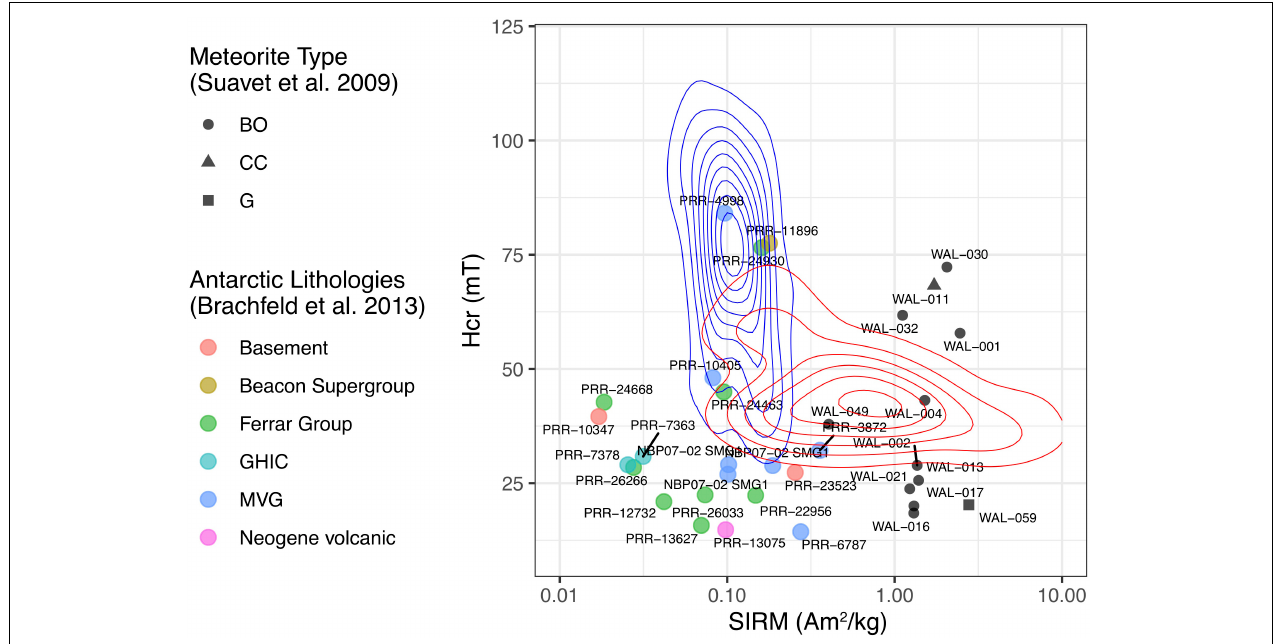
FIGURE 7 | Semi-logaritmic SIRM/H cr diagram of rock-magnetic data from the Dry Valley (Brachfeld et al., 2013) and of micrometeorite samples from Suavet et al. (2009). Samples labels and groups correspond to that of original data, micrometeorite groups are divided in BO (Barred Olivine), CC (Cryptocrystalline), and G (G-type cosmic spherules). The SIRM dust data from ice cores are reported for comparison as their density estimates as in Figure 6 . SIRM of Dry Valley rocks are not significantly different from that of PSA samples from the same area and are compatible with glacial dust but they have, on average, a lower H cr , Magnetic properties of micrometeorites are compatible with that of interglacial aerosol dust except for the larger variability of H cr . However, to explain the total amount of magnetic minerals found in the ice would require a micrometeorite flux ranging from 2 × 10 − 7 to 2 × 10 − 6 (kg/m 2 year). Extrapolated to the whole Earth surface (5.1 × 10 14 m 2 ) this corresponds to a total flux from ca. 102 to ca. 1020 (kt/year), which is orders of magnitudes higher than current estimates of ca. 160 ± 60 t/year (Prasad et al.,